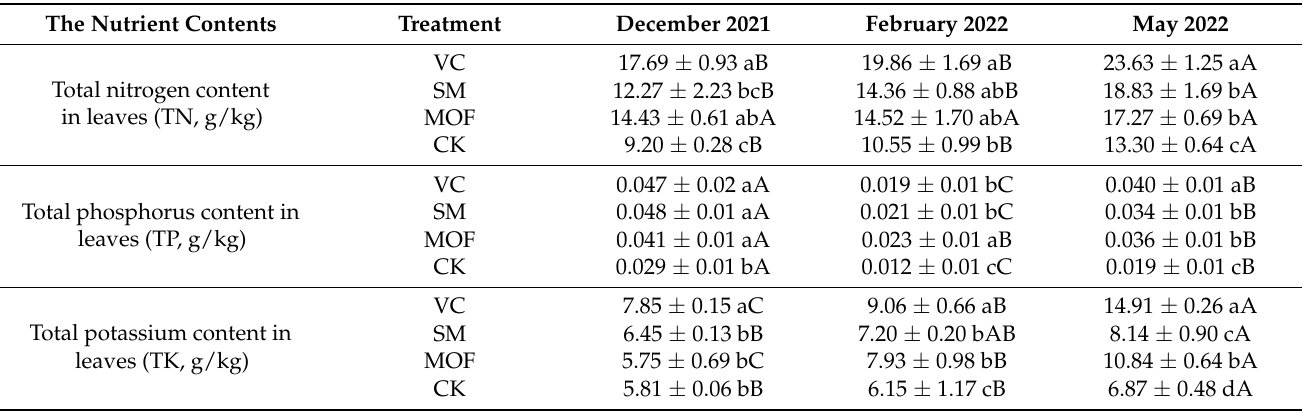
Table 3. Effects of different bio-organic fertilizer treatments on the nutrient content of “Qi-Nan” agarwood seedlings.